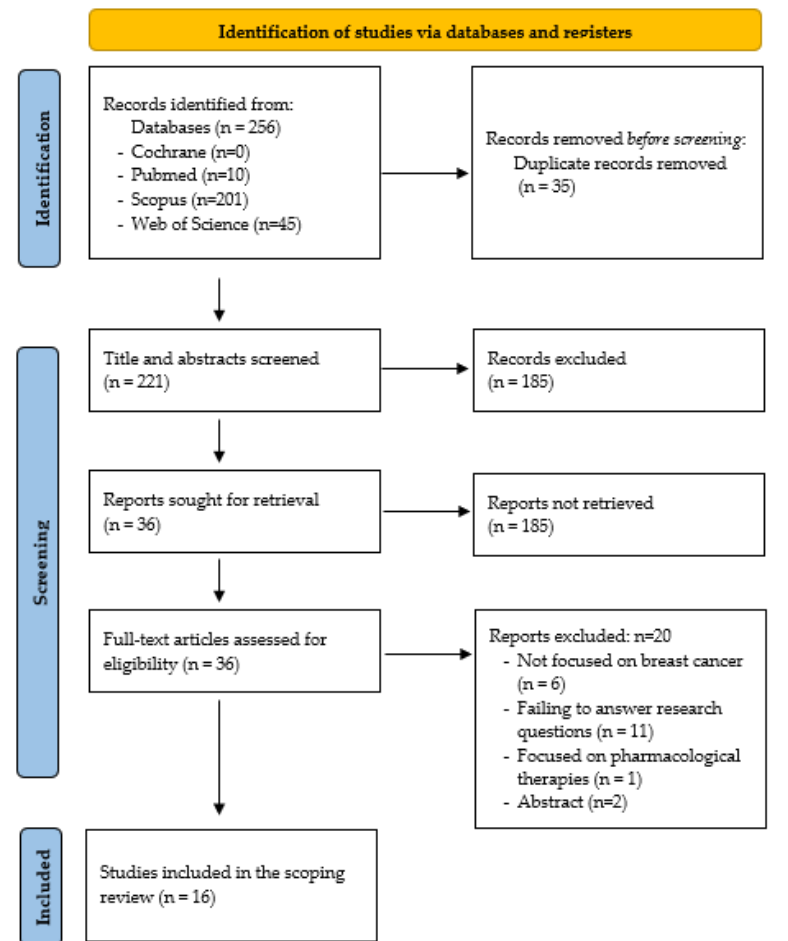
Figure 1. PRISMA flow diagram showing the studies included and excluded [14].